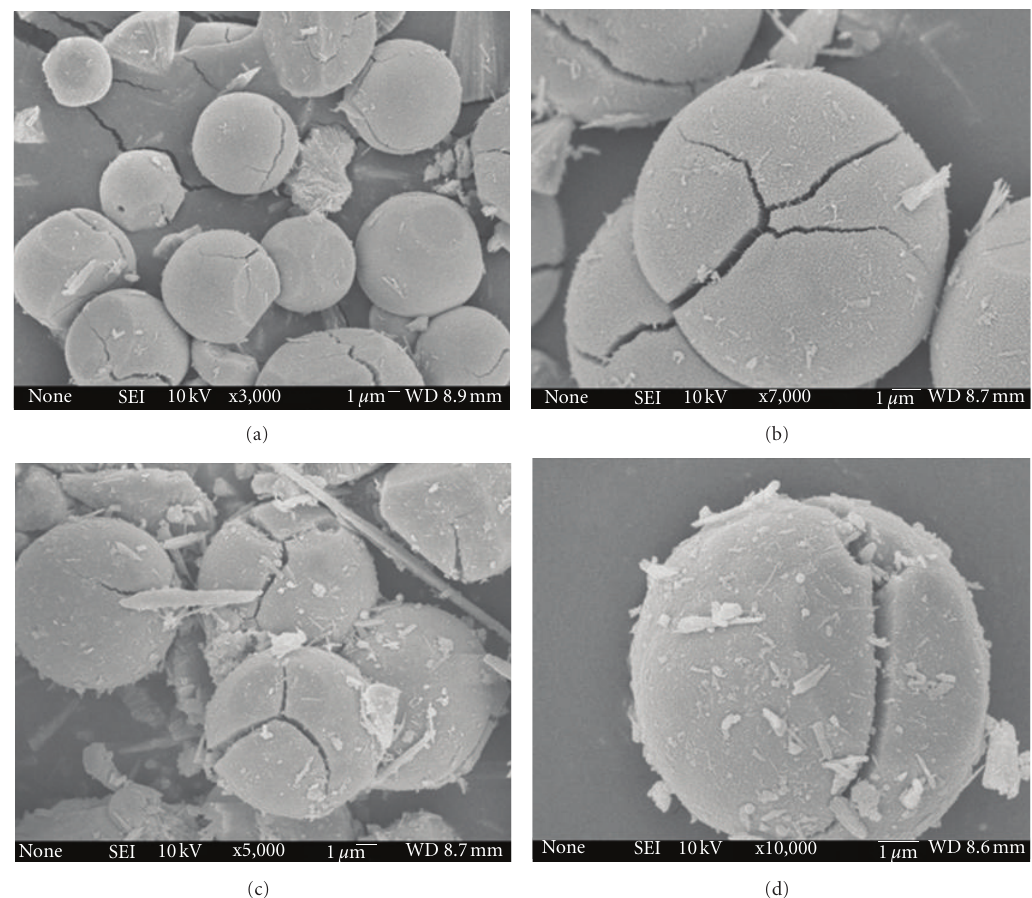
Figure 1: SEM images of the samples: (a, b) PureTiO 2 and (c, d) 1.0-Pt-TiO 2